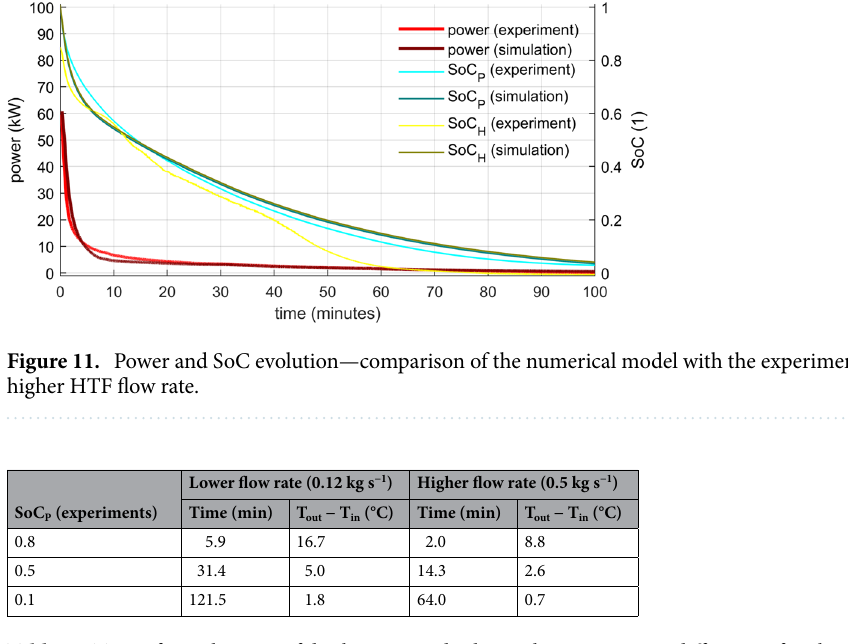
Table 3. Times from the start of discharging and inlet/outlet temperature differences for chosen SoC values.